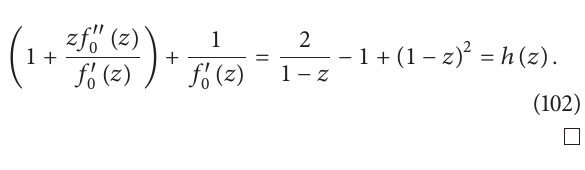
that the function 𝜒 𝑖 satisfies the required condition.